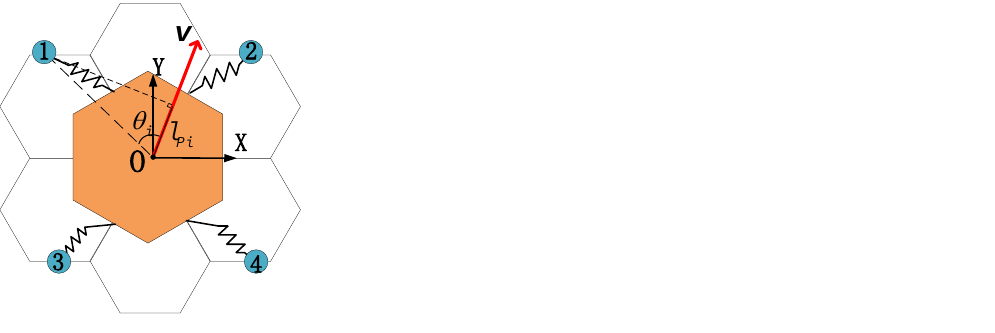
Figure 3. Schematic diagram of space robot robotic arm numbering. The numbers are manually calibrated to facilitate the description of relative positional relationships.